Question: Sum up the contents of this chart in one sentence.
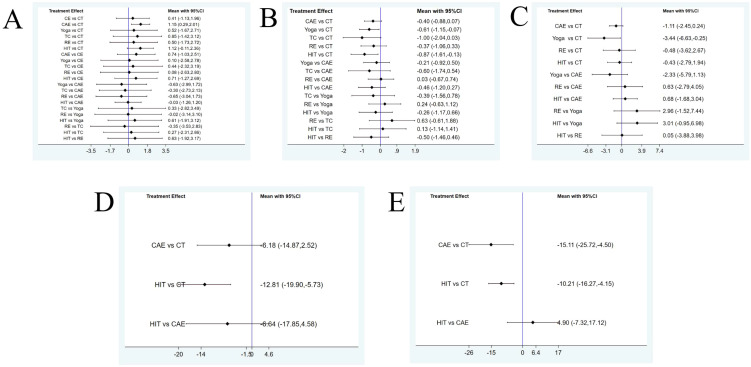
Answer: Forest plots of the network meta-analysis for the principal outcomes. (A) Quality of Life; (B) Disease Activity; (C) Fatigue Severity; (D) IL-6; (E) TNF-α. The figure presents pooled effect estimates with 95% confidence intervals for the principal outcomes included in the network meta-analysis. Effect estimates are expressed as mean differences or standardized mean differences, as appropriate. CT, Conventional Therapy; CE, Combined Aerobic and Resistance Exercise; CAE, Continuous Aerobic Exercise; TC, Tai Chi; RE, Resistance Exercise; HIT, High-intensity Interval Training.